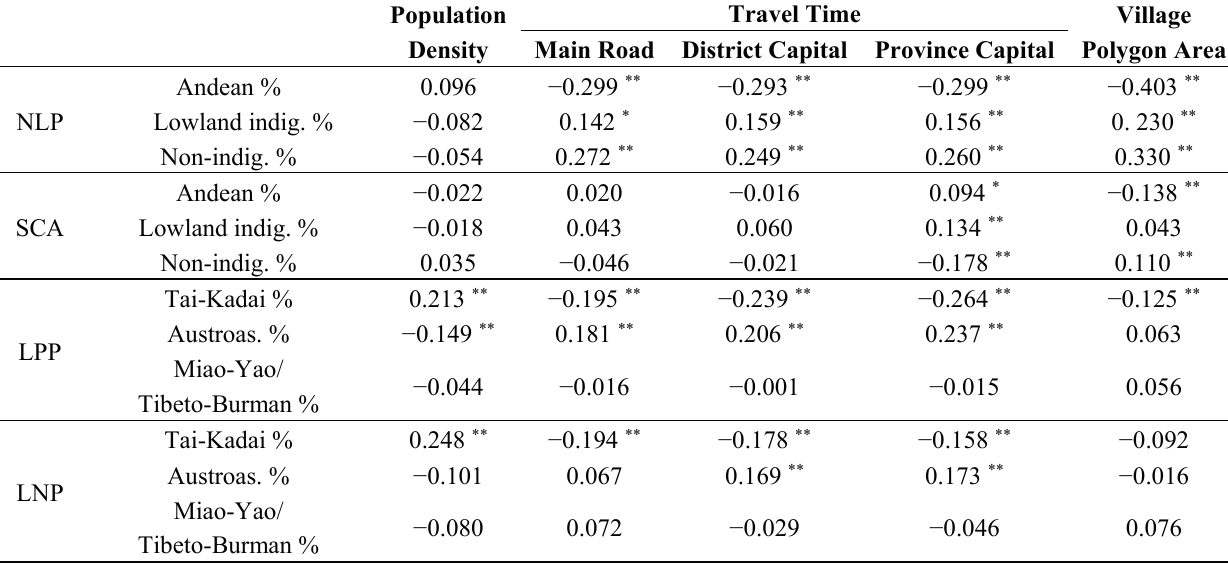
Table 3. Ethnicity in relation with other socio-economic variables. Travel Time Population Density